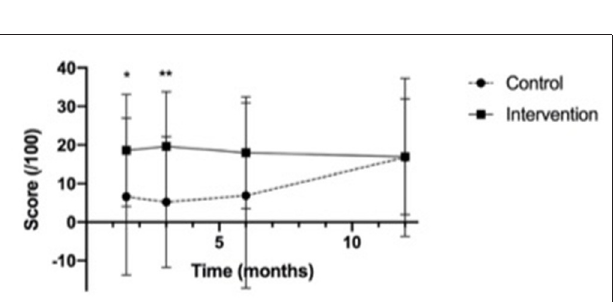
FIGURE 5 | Change in mean self-efficacy assessment scores from baseline. *p-value < 0.05, **p-value < 0.01, referring to the difference in scores between the control and intervention groups at 6 weeks and 3 months